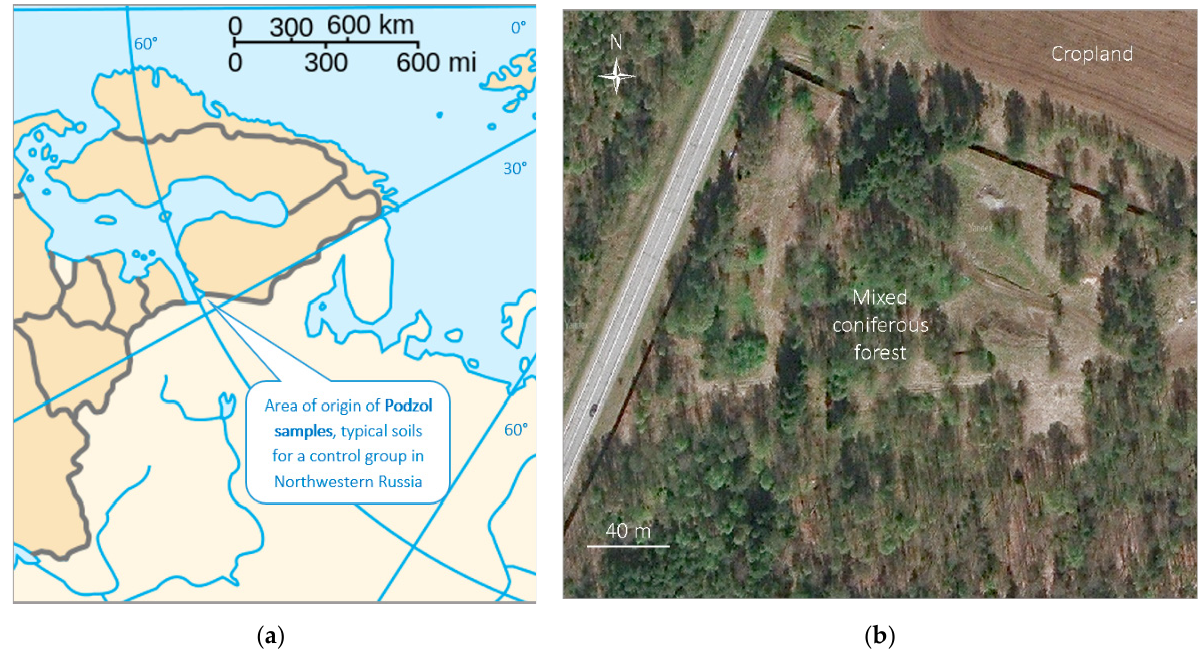
Figure 2. Soil sampling area: ( a ) provenance of typical soils of coniferous woodlands in Leningrad Oblast (based on the free blank map, commons.wikimedia.org); ( b ) agricultural land and forest shelter belts with disturbed Podzols westwards and southwards of a cleared field of the rural settlement of Agalatovo (based on the Yandex satellite image).